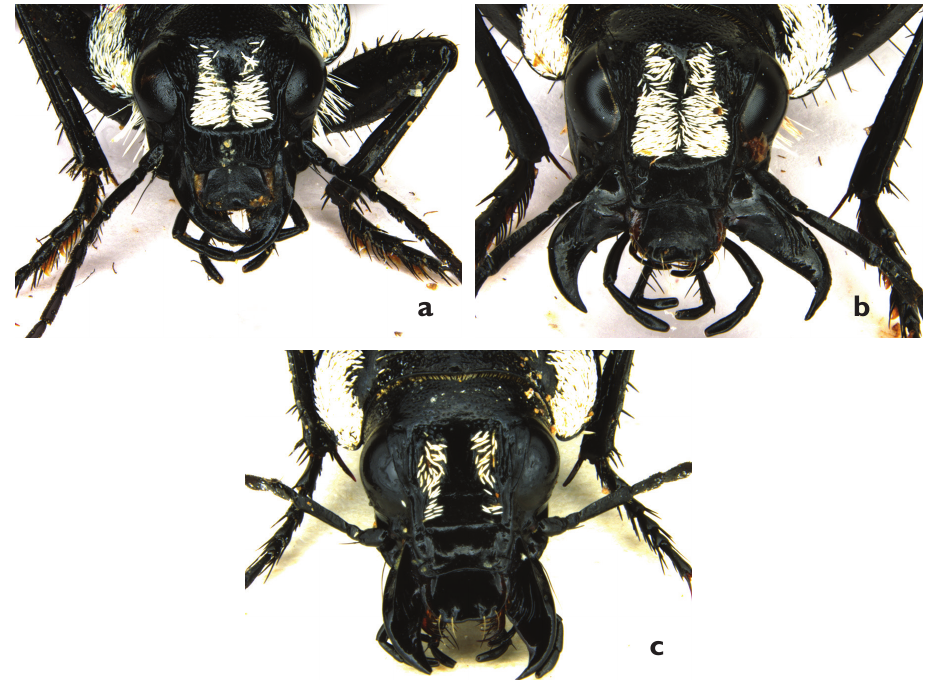
Figure 4. Frontal white stripes of white scales in both sexes: a Male: apical white frons stripes wider than exposed frons ( G. multiguttatus ) b Male: apical white frons stripes slender than exposed frons ( G. serrator ) c Female: sparse stripes of scales ( G. serrator ).